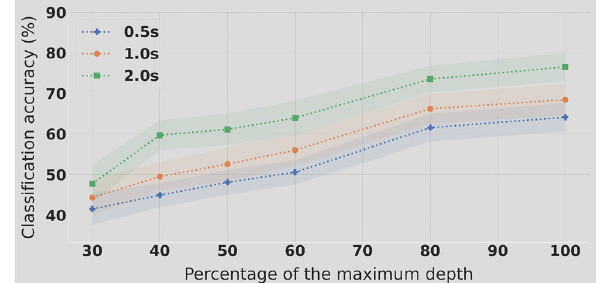
Figure 5. Experiment 2: classification accuracy in % using 4 classes (32, 34, 36 and 38 Hz) in function of different levels of amplitude stimulation depth and considering 3 epochs